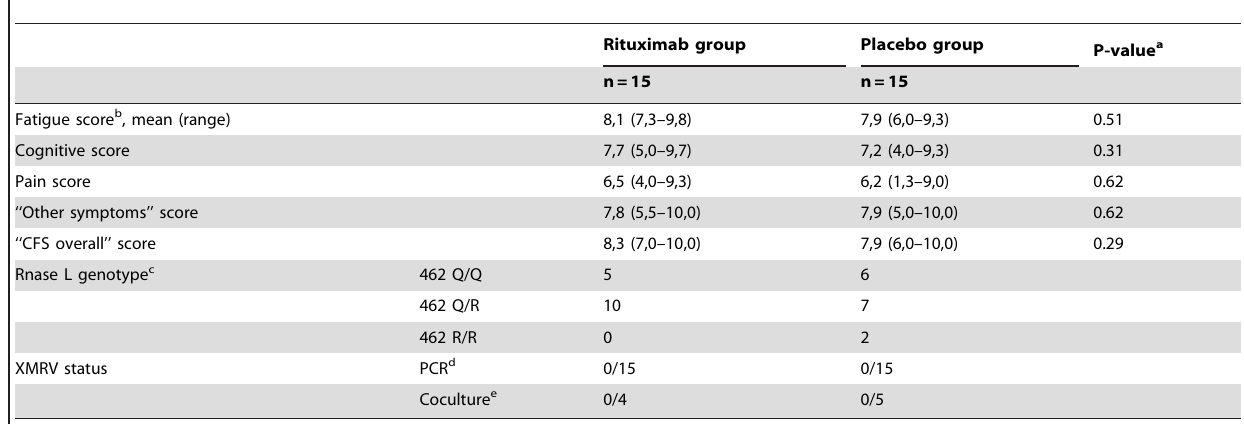
Table 2. Baseline self-reported symptom scores, RNase L genotype, and XMRV status, for patients in the Rituximab and Placebo